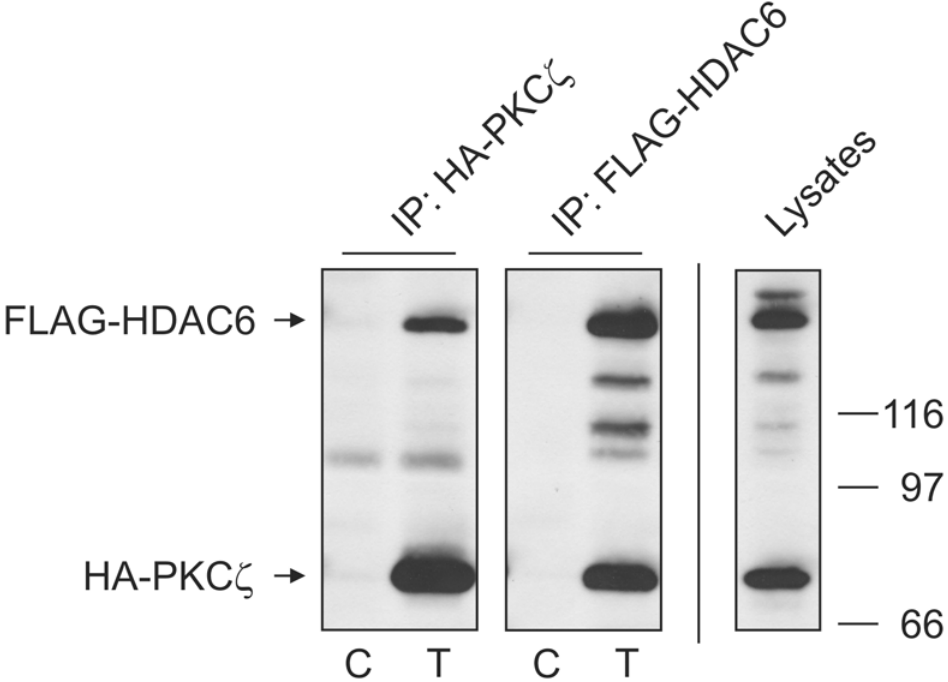
Fig 1. Atypical PKC ζ exists in a complex with HDAC6. HA-PKC ζ and FLAG-HDAC6 were transfected into HEK cells and reciprocal immunoprecipitations performed using antibodies for each tag as described in Materials and Methods. Control lanes (C) were transfected with empty plasmid while sample lanes (T) were transfected with both HA-PKC ζ and FLAG-HDAC6. 40 μ g of whole cell lystate (Lysate) was loaded to show construct expression in transfected cells. Co-precipitating bands were detected by SDS-PAGE and Western blot with tag-specific antibodies. Results are indicative of 3 independent